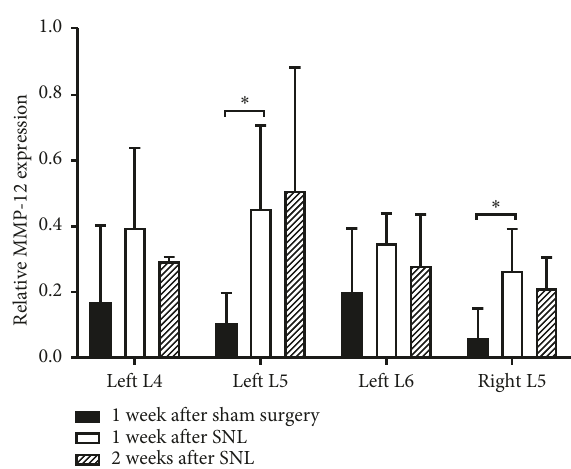
Figure 3: MMP-12 upregulation in ligated left L5 spinal nerve is observed for up to 2weeks. MMP-12 activity of spinal nerves at 1 ( n � 5) or 2 ( n � 4) weeks after SNL and 1week after sham surgery ( n � 5) was compared. Statistically significant differences between groups for each spinal nerve were determined by Mann–Whitney U test ( ∗ p < 0 .